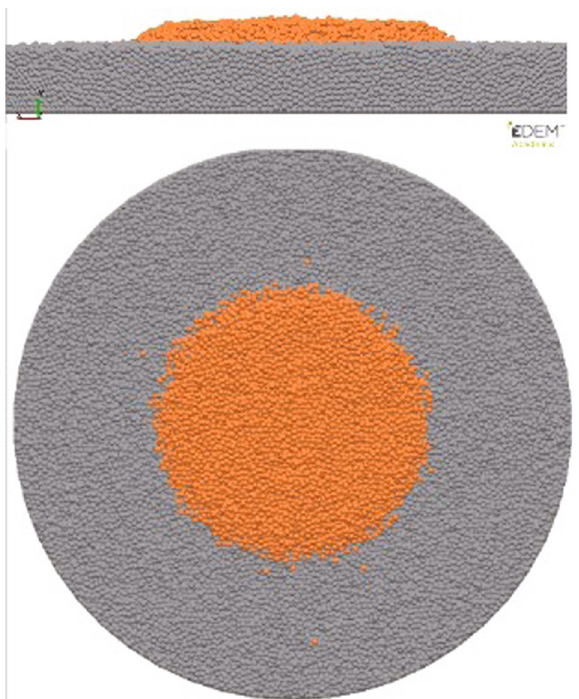
Figure 9: Single spherical discrete element lunar soil model.